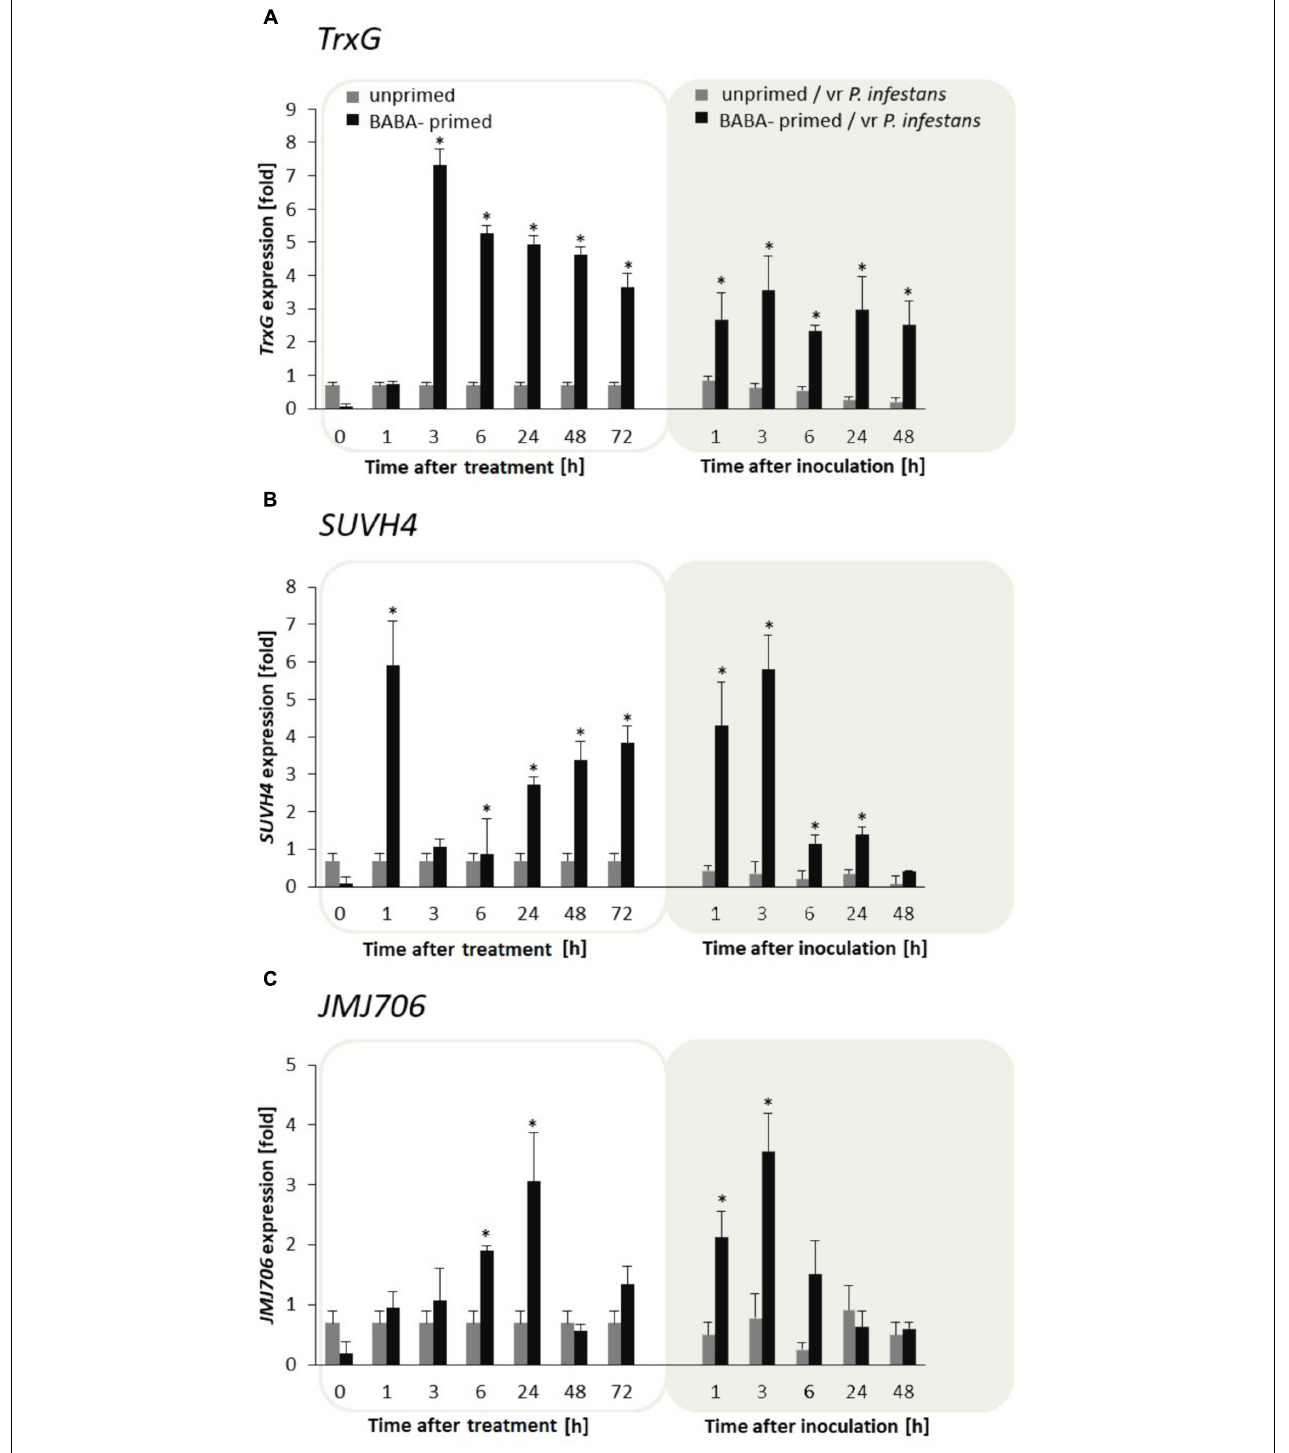
FIGURE 5 | Histone lysine methyltransferases and demethylase are required for BABA-triggered immunity. Transcription changes in TrxG , SUVH4 , and JMJ706 gene expression in BABA-primed leaves of F 0 potato plants followed by challenge inoculation with P. infestans (A) . Analyses were performed at 1–48 h after 5 mM BABA exposure (white background) and 1–48 hpi after challenge inoculation (gray background). Transcriptional priming of TrxG , SUVH4 , and JMJ706 gene expression after P. infestans inoculation in the offspring of BABA-primed F 1 - vegetative line (B) , and F 1 - generative line (C) . Light columns refer to unprimed, while dark columns - to primed plants progeny. Values represent means of data ± SD of at least three independent experiments. Asterisks indicate values that differ significantly from unprimed (water treated) or unprimed and P. infestans inoculated potato leaves at P < 0.05 ( ∗ ), respectively.